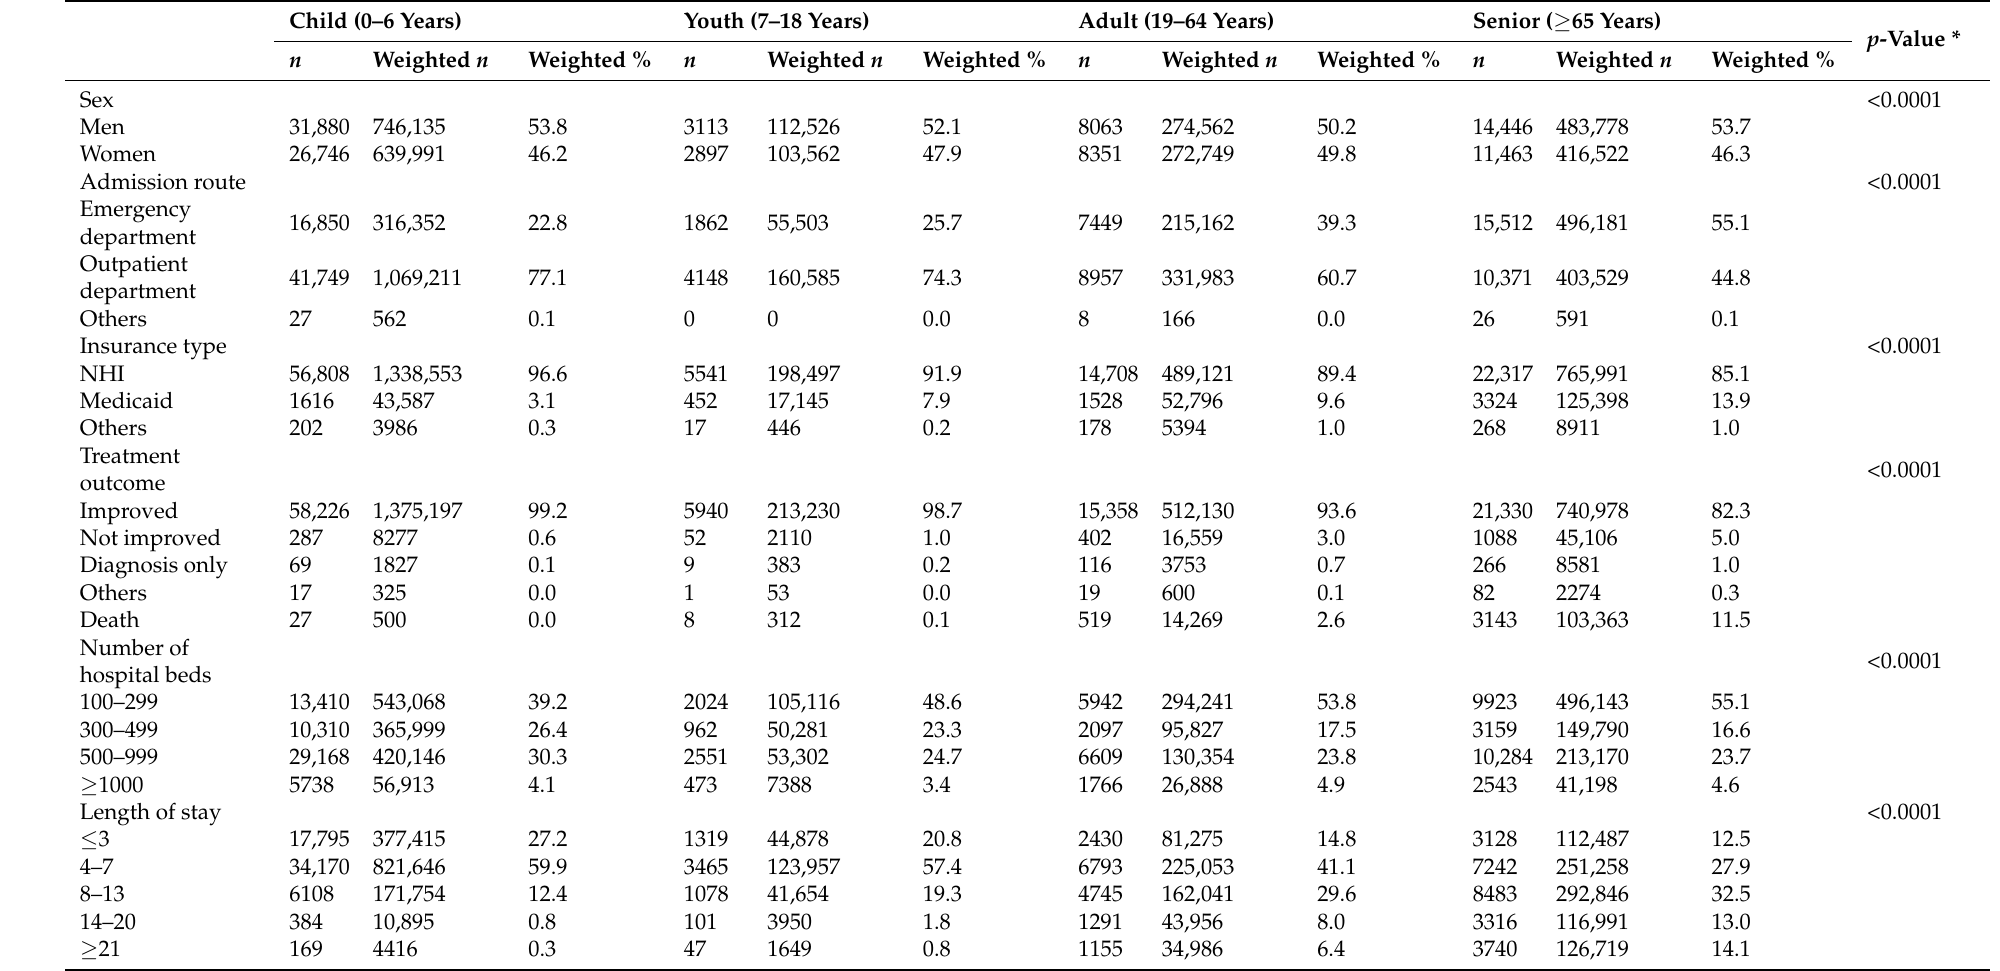
Table 1. Demographic characteristics and admission information of discharged pneumonia patients in South Korea in each age group